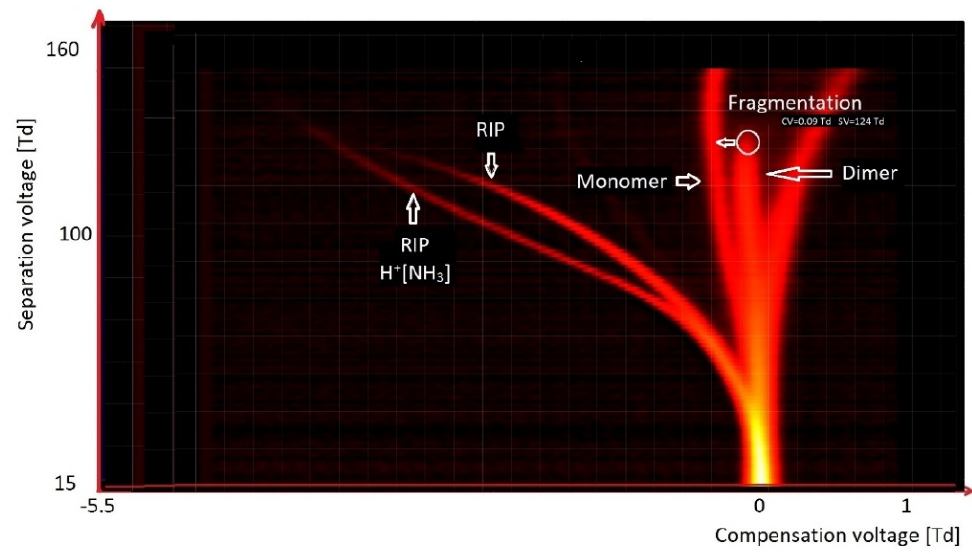
Figure 9. DMS spectrogram of octanone, with identification of basic peaks.